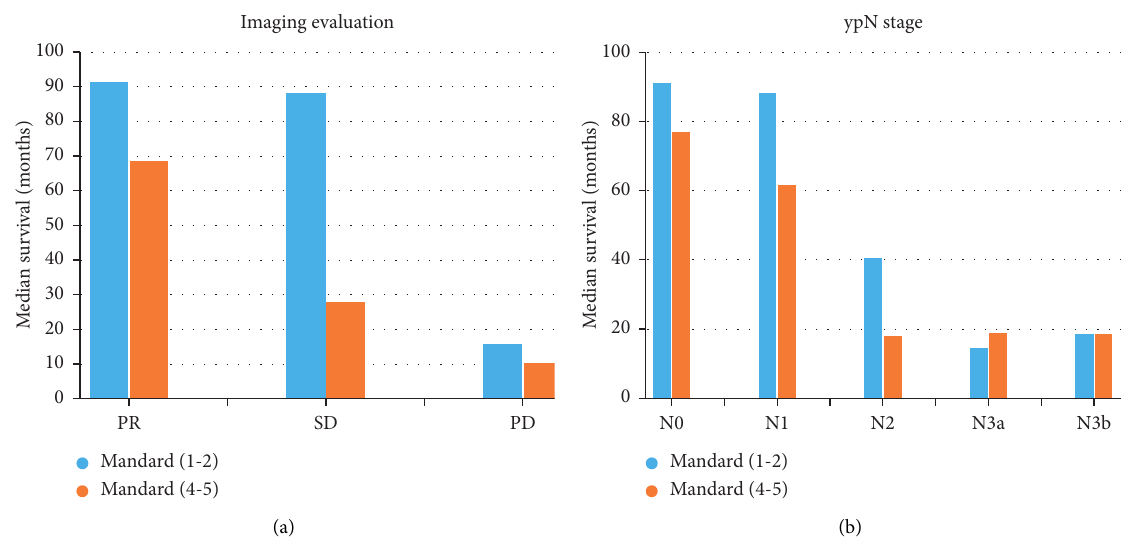
Figure 4: Median survival time for the Mandard score (1-2) group and the Mandard score (4-5) group. (a) By the imaging evaluation group. (b) By the ypN group. Table 3: Multivariable Cox regression analysis of clinicopathologic variables in relation to overall survival. Clinicopathological